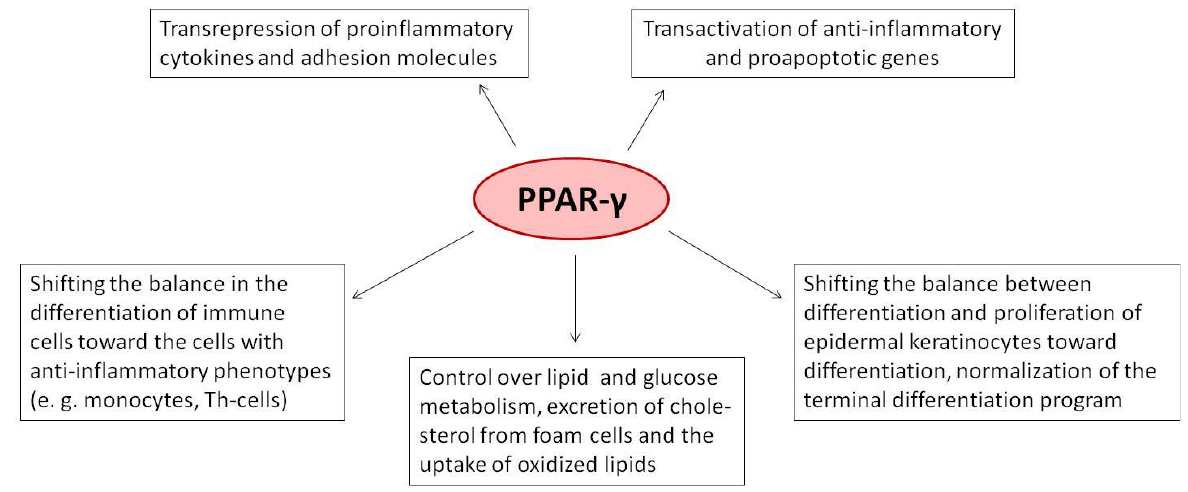
Figure 5. The role of PPAR- γ in the pathogenesis of psoriasis.